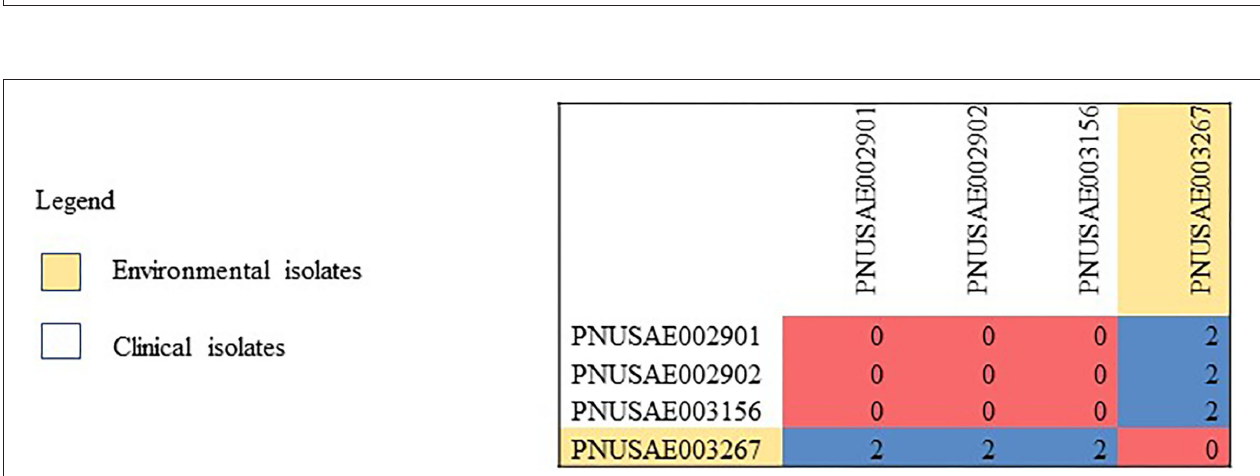
FIGURE 2 | High-quality single nucleotide polymorphism (SNP) analysis of E. coil O103 sequences ( n = 4) from isolates resulting from testing of clinical samples ( n = 3) and environmental samples from goat hay bedding ( n = 1) during an outbreak of illness linked to a goat farm in Connecticut. Clinical and environmental isolates were highly related genetically within 0–2 SNPs. The high-quality SNP analysis had phages masked, an internal reference PNUSAE003156-CT-M4158-160517_ filtered_chromosomes.fasta, and was generated with Lyve-SET version 1.1.4f. Reads were cleaned with CG Pipeline (options: –no-singletons). SNPs were called with Varscan, and Lyve-SET was run with the following options: minimum coverage − 20, min alternative fraction − 0.95, and allowed flanking − 5 bp.